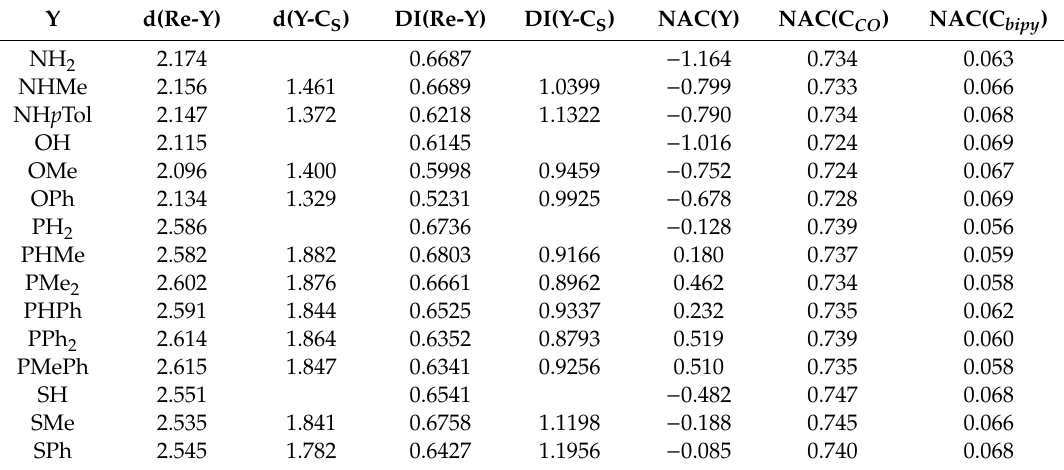
Table 2. Bond distances between Re and the heteroatom of the Y ligand and between the heteroatom and the carbon of the alkyl or aryl substituent directly linked to it (d(Re-Y) and d(Y-C S ) in Å, respectively), electron delocalization indexes at the bond critical points located between each of the two pairs of atoms mentioned above (DI(Re-Y) and DI(Y-C S ), respectively), and net natural atomic charges of the nucleophilic atom of the Y ligand, the attacked carbon of the carbonyl ligand in cis disposition to the Y ligand, and the attacked non-substituted ortho carbon of the bipy ligand (NAC(Y), NAC(C CO ), and NAC(C bipy ) in e , respectively) of the reactant complexes [ReY(CO) 3 (bipy)] (Y = NH 2 ,